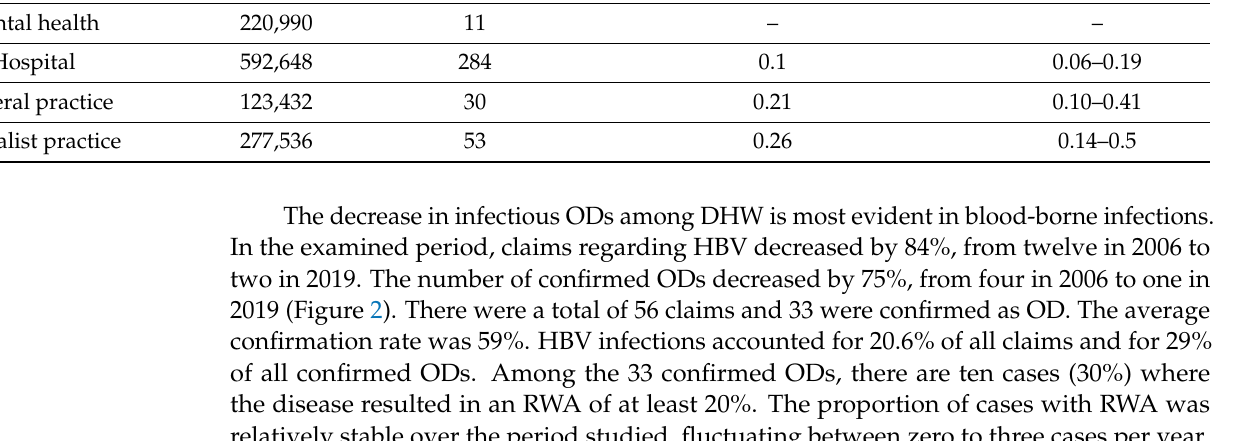
Table 3. Non-infected full-time equivalents, number of infections by workplace and odds ratios (OD) for dental health workers (DHW) compared with hospital, general practice and specialist practice workers. Worker No Infection Infection Odds Ratio for Dental Health Workers 95%CI Dental health 220,990 –